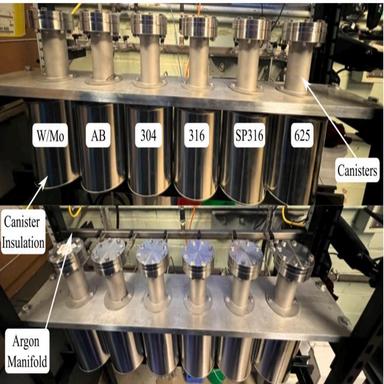
Image showing the setup of the canisters holding the samples submerged in liquid lithium. The argon feed and canister insulation are also seen. Each canister is labelled with the corresponding material. Refer to Table 1 to compare the abbreviated names to full material names.